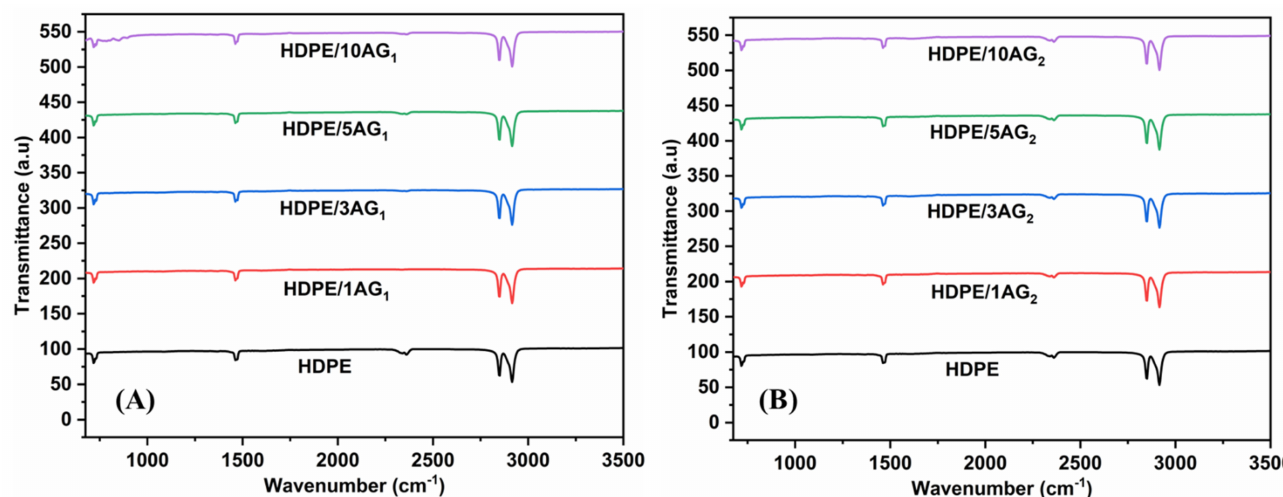
Figure 2. ATR-FTIR data of HDPE and HDPE/AG 1 ( A ) and HDPE/AG 2 ( B ) composites.